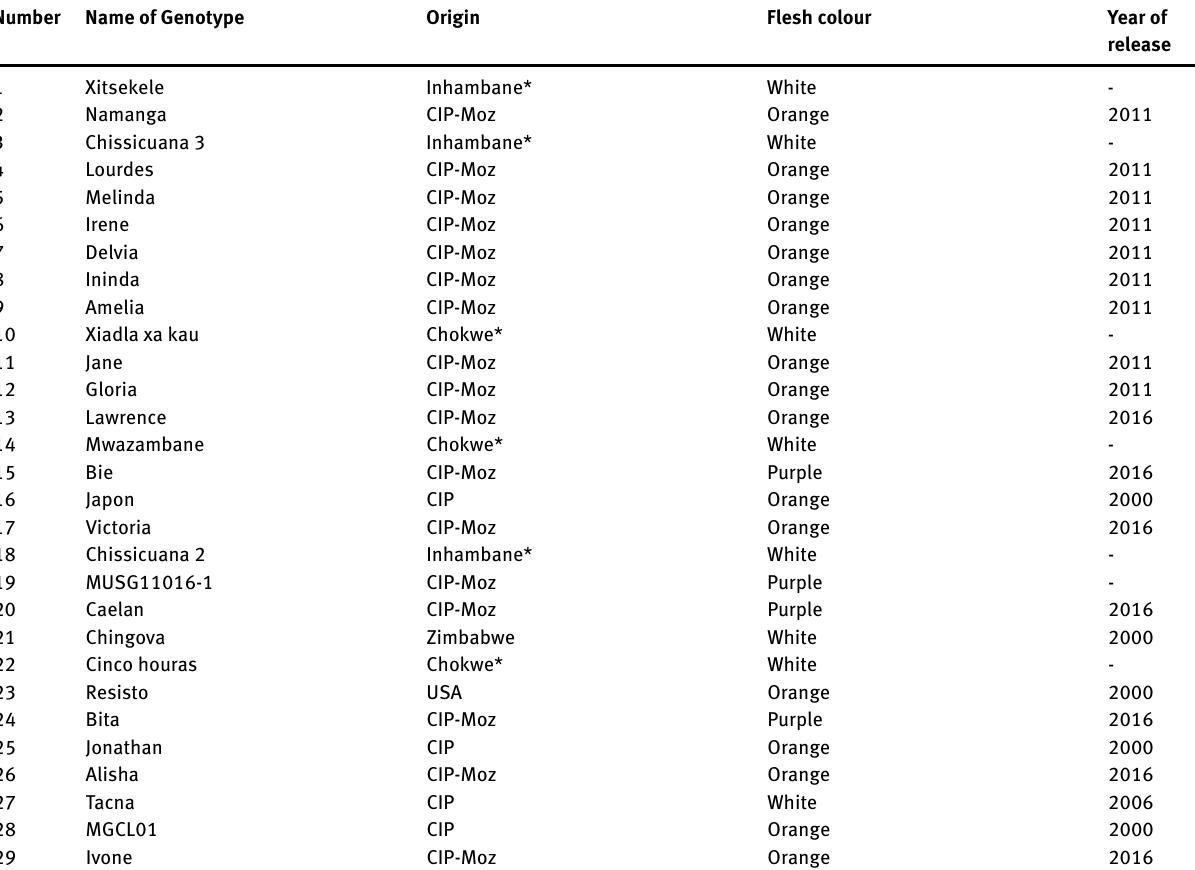
Table 1: Genotypes evaluated for sprouting and ability to provide vines for the next crop at Umbeluzi Research Station and Nwalate Farm in southern Mozambique in 2015, 2016 and 2017 Number Name of